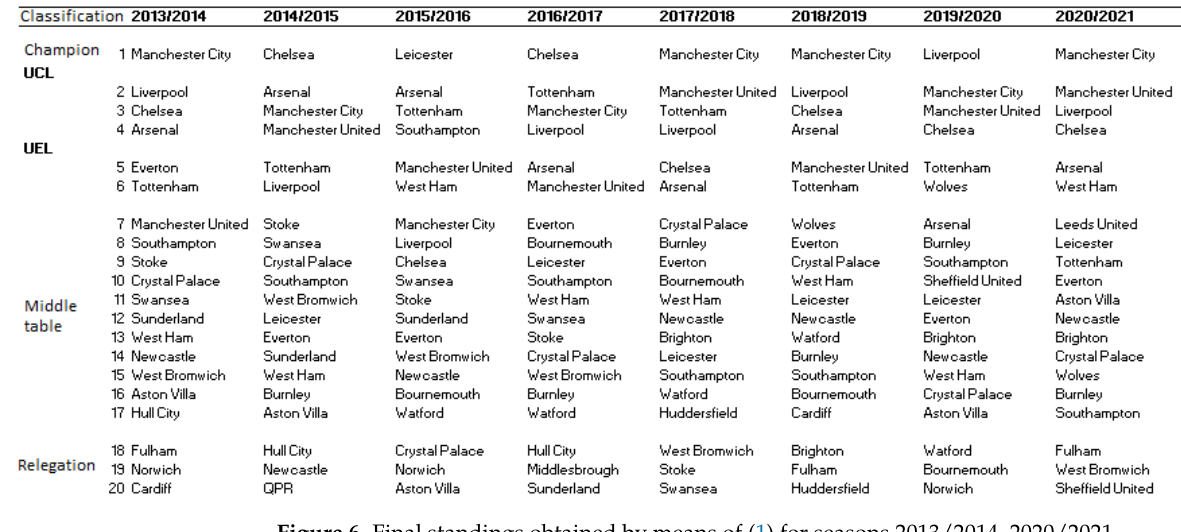
Figure 6. Final standings obtained by means of (1) for seasons